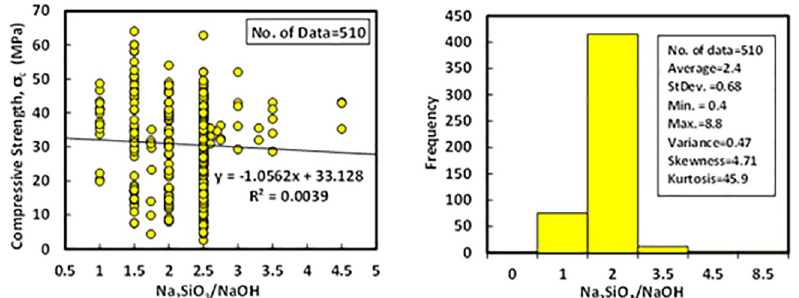
Fig 9. Variation between compressive strength and (SS/SH) ratio with a histogram of fly ash-based geopolymer concrete mixtures.